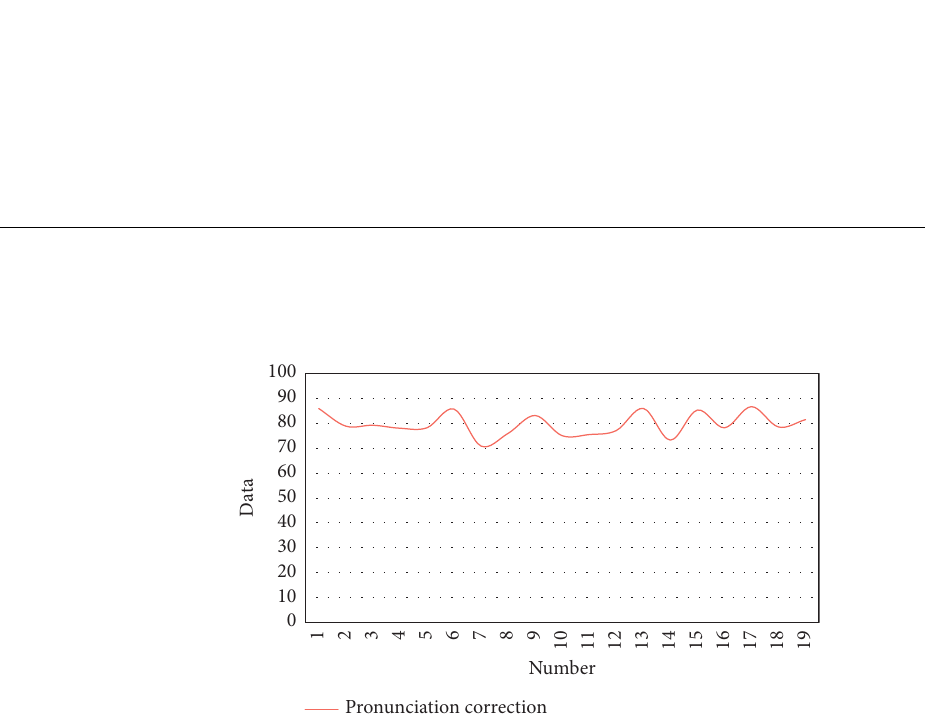
Figure 10: Statistical diagram of evaluation of pronunciation correction effect of spoken English reading.